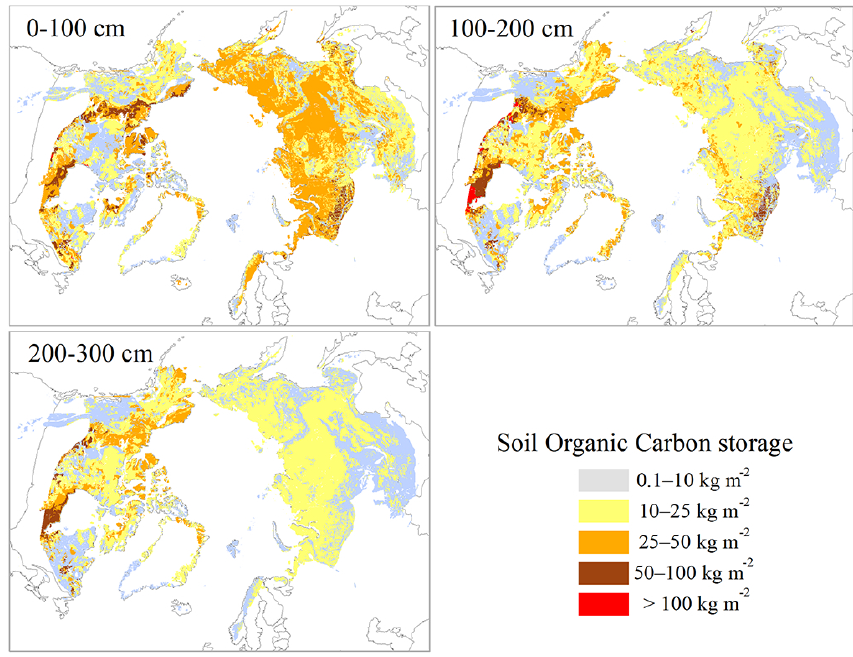
Figure 2. Estimated SOC storage (kgCm − 2 ) in the 0–100cm, 100–200cm and 200–300cm depth ranges of the northern circumpolar permafrost region. Note that the data is normalised for total polygon area (including non-soil areas) unlike Figure 1 in Hugelius et al. (2013) where the data is normalised to polygon soil area (Map projection: Azimuthal Equidistant, geodetic datum: